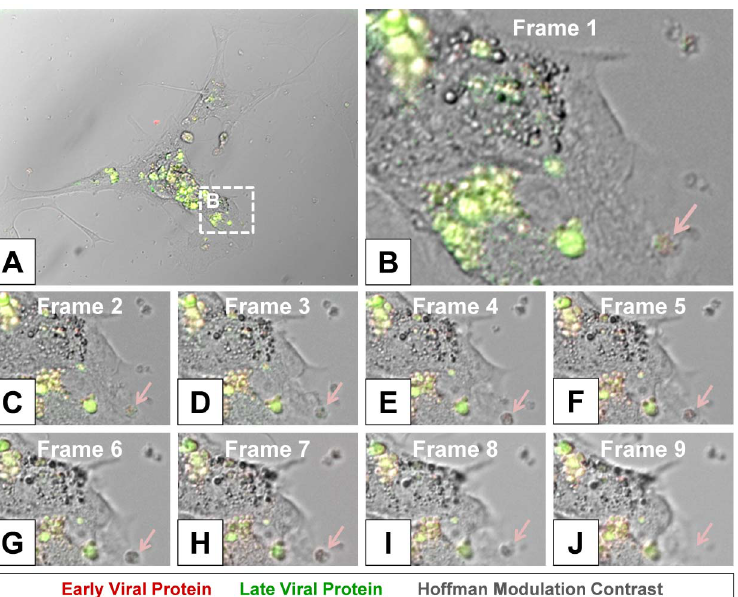
Figure 8. Time lapse photography frames showing microvesicle egress from a Timer-CVB3-infected cell. (B–I) Close inspection of image (A) taken at 15 minute intervals in differentiated NPSCs infected with Timer-CVB3 and observed during a six hour span revealed intracellular membrane reorganization (first 8 frames shown). (J) An intracellular microvesicle expressing matured ‘‘fluorescent timer’’ protein and formed following Timer-CVB3 infection was released from the infected cell (frame 9; pink